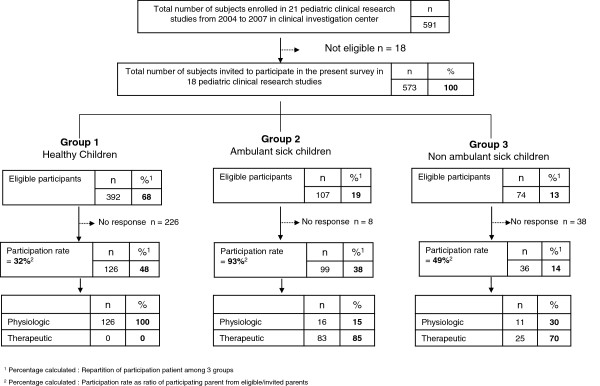
Summary of recruitment process and ratio of physiologic/therapeutic pediatric clinical research study.